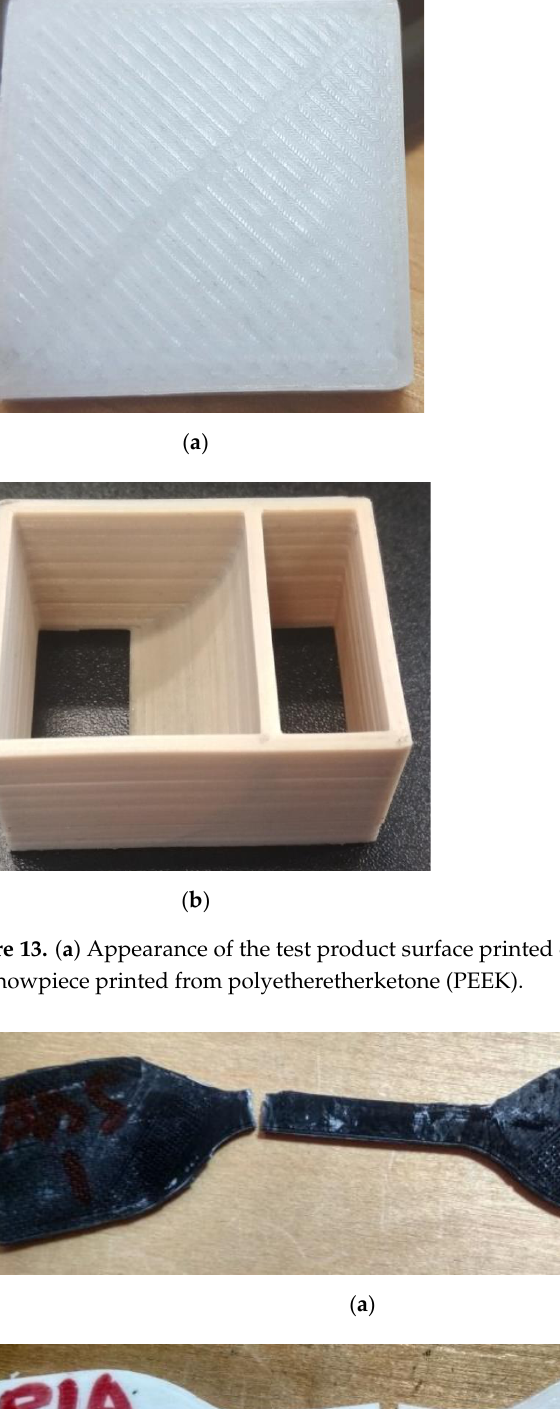
printing parameters as given in Table 3. Table 3. Fused deposition modeling (FDM) 3D-printing process parameters.